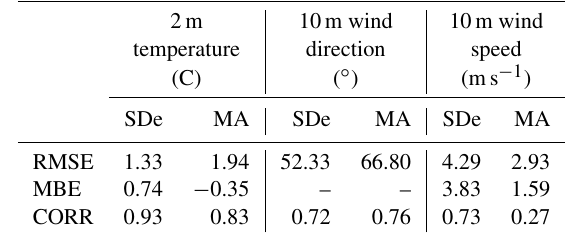
Table 2. Overview of the meteorological evaluation of the surface measurements at the two sites. The root mean square error (RMSE), mean bias error (MBE), and Pearson correlation coefficient (CORR) are